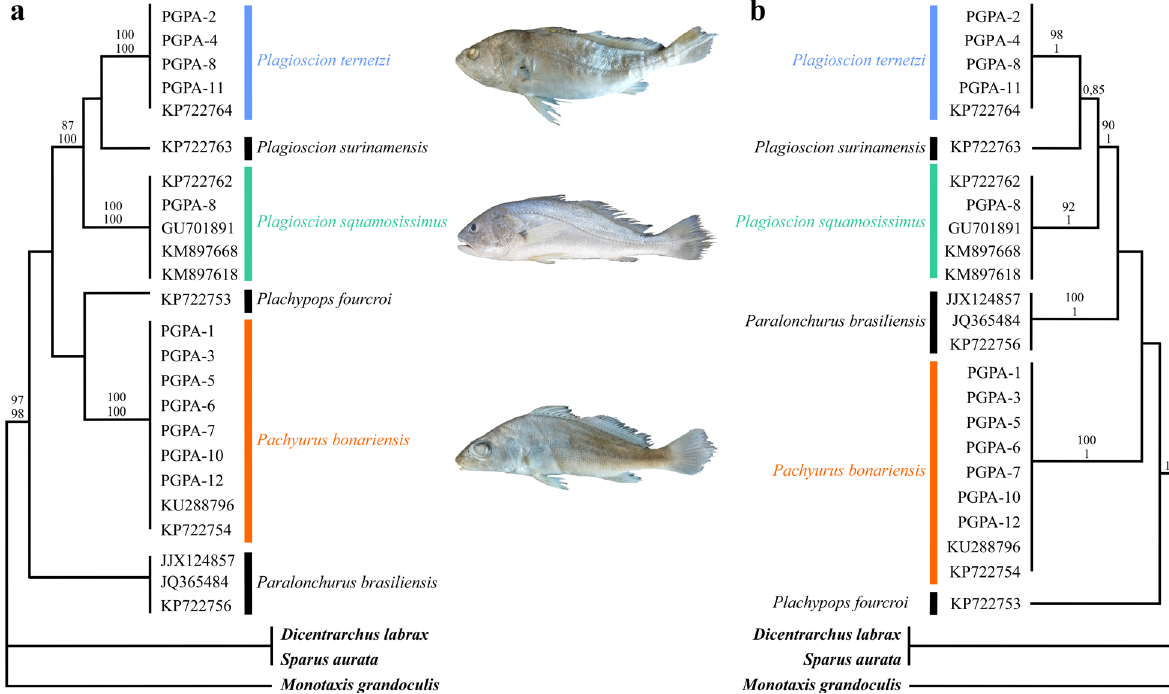
Figure 3. Phylogenetic and distance trees of species of the Family Sciaenidae based on 615 nucleotides of the mitochondrial gene COI . Tree of Neighbour-Joining, Maximum Parsimony, Maximum Likelihood and Bayesian Inference. Bootstrap values for: (a) NJ and MP; (b) ML and a posteriori probability values for BI, respectively, are shown above the branches. Values below 70/0.7 are not shown. References for the sequences correspond with the collection numbers assigned by the “Proyecto de Biología Pesquera Regional” for material from the Garupá Stream and access numbers from GenBank for the remaining